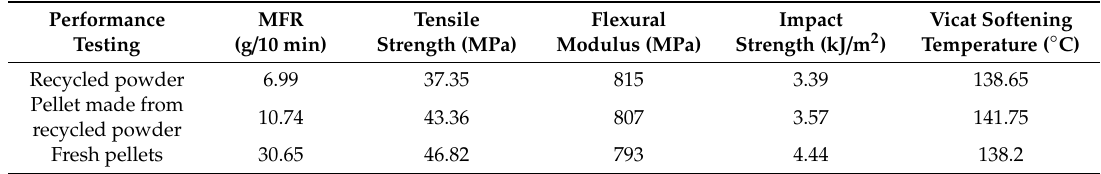
Table 1. Performance comparison of Polyamide 12 (PA12) powder and fresh